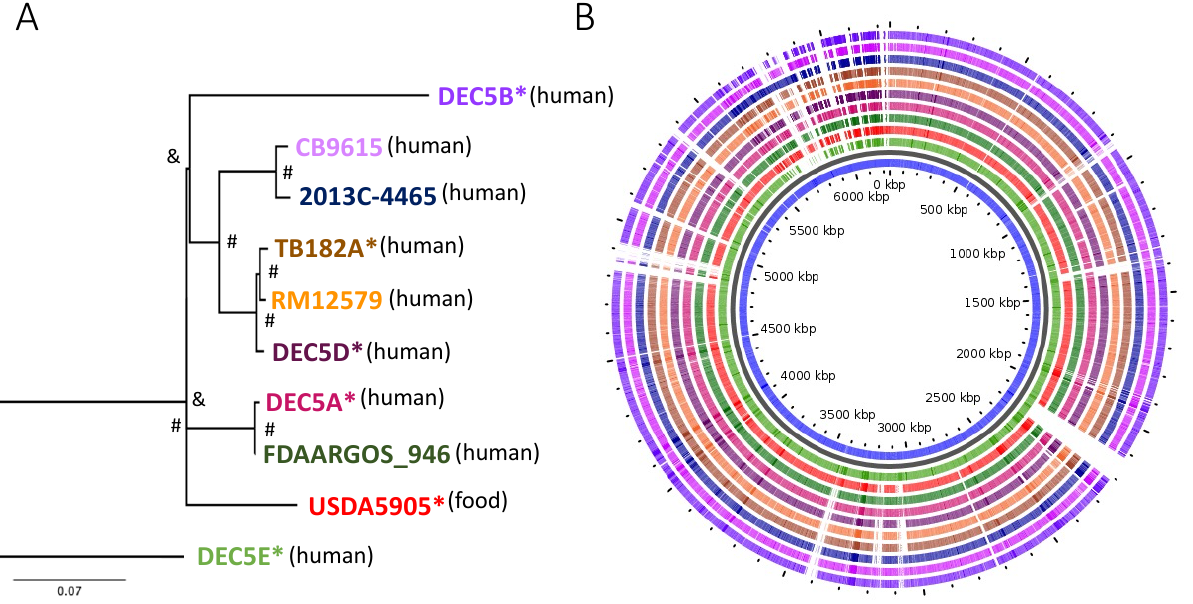
Figure 1. ( A ) Phylogenetic tree of the core regions from the chromosomes of E. coli O55:H7 strains, with newly sequenced chromosomes denoted with an asterisk (*). The tree was constructed using Parsnp with 6860 core chromosome-derived SNPs. Bootstrapping values were assigned using UFboot and SH-aLRT, with values above 95% represented by a hashtag (#) and values below represented by an ampersand (&). The source of the isolate is in parenthesis next to the strain name. ( B ) The pangenome of the chromosomes from E. coli O55:H7 strains using GView. The colored rings match the color of the strains at the end of the branches of the phylogenetic tree in ( A ) with blank areas representing a section of chromosome not found within a strain. The inner blue circle is the complete pangenome of the chromosomes. Strain DEC5E was used as the seed genome to build the pangenome.